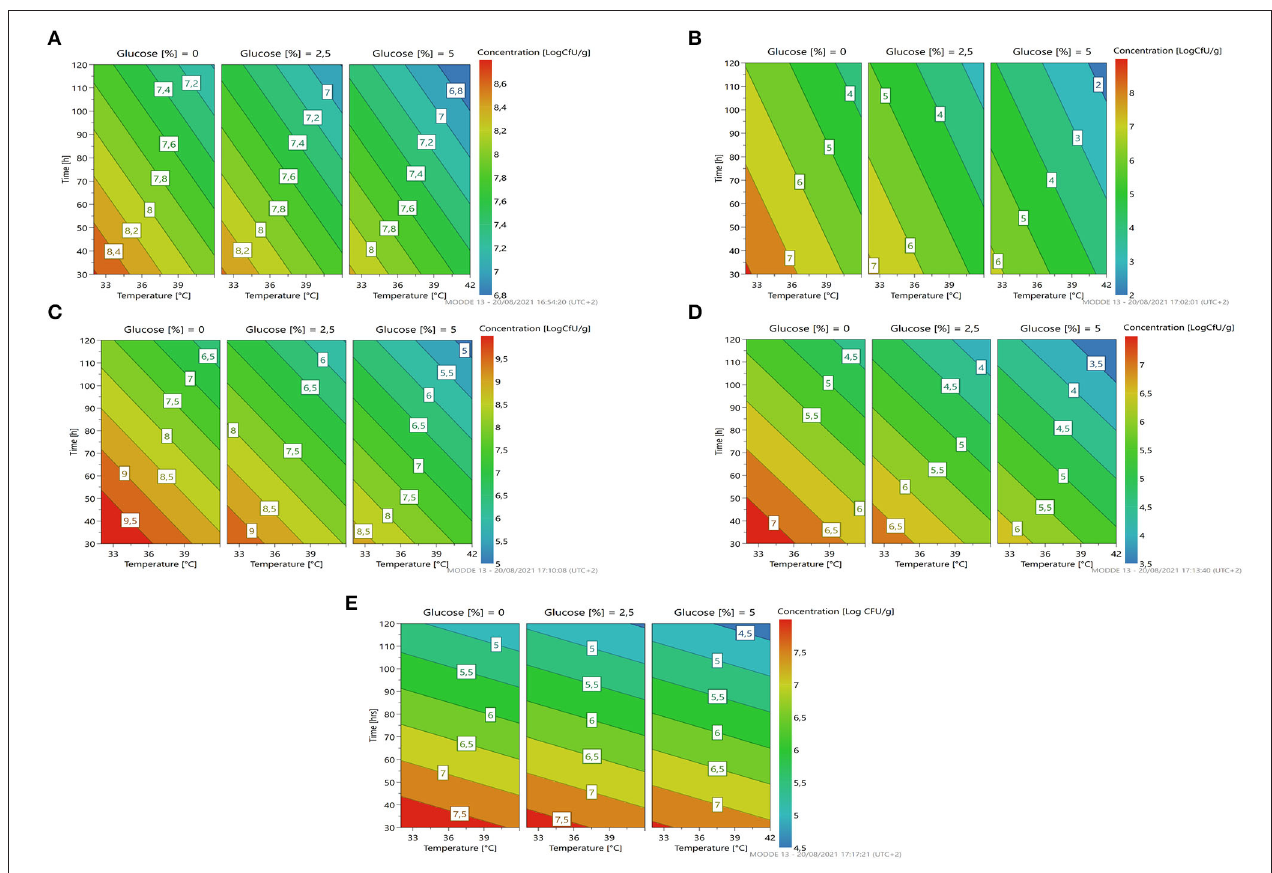
FIGURE 3 | A response contour plot of concentration (Log cfu/g) of Lacticaseibacillus rhamnosus 1473 (A) ; Lacticaseibacillus paracasei 4186 (B) ; Lacticaseibacillus casei 2240 (C) ; Lactiplantibacillus plantarum 4932 (D) ; Pediococcus acidilactici 3992 (E) in samples without seeds, with time and temperature as main factors and with glucose